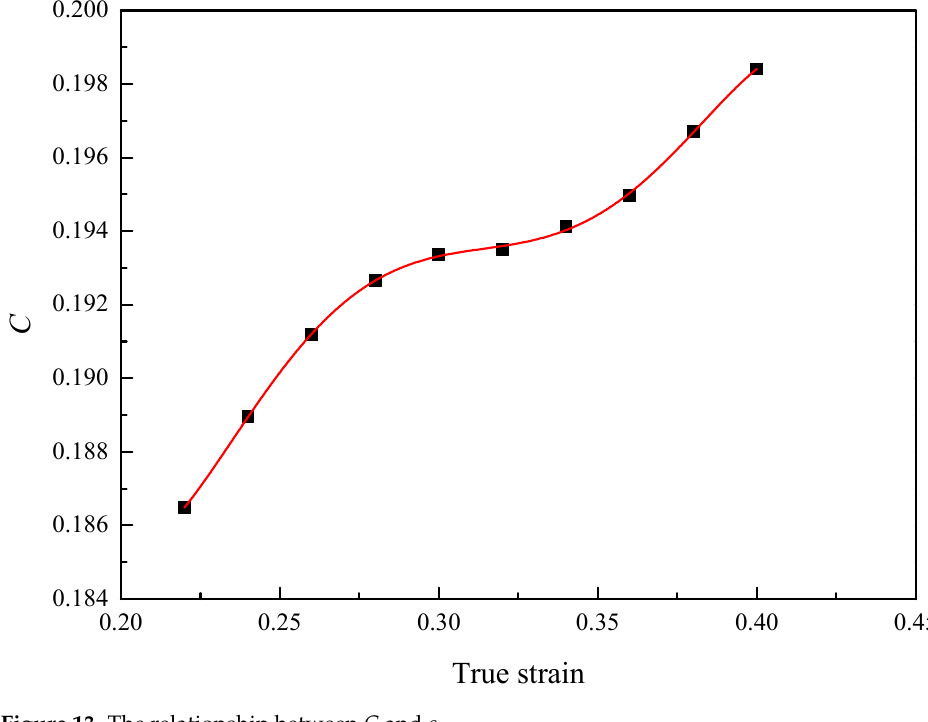
Figure 13. The individual parameters in the fifth polynomial of C( ε ) can be calculated by Figure 12. The true stress − true strain curve in reference temperature and strain rate. polynomial fitting, and the values of the parameters are shown in Table 3.